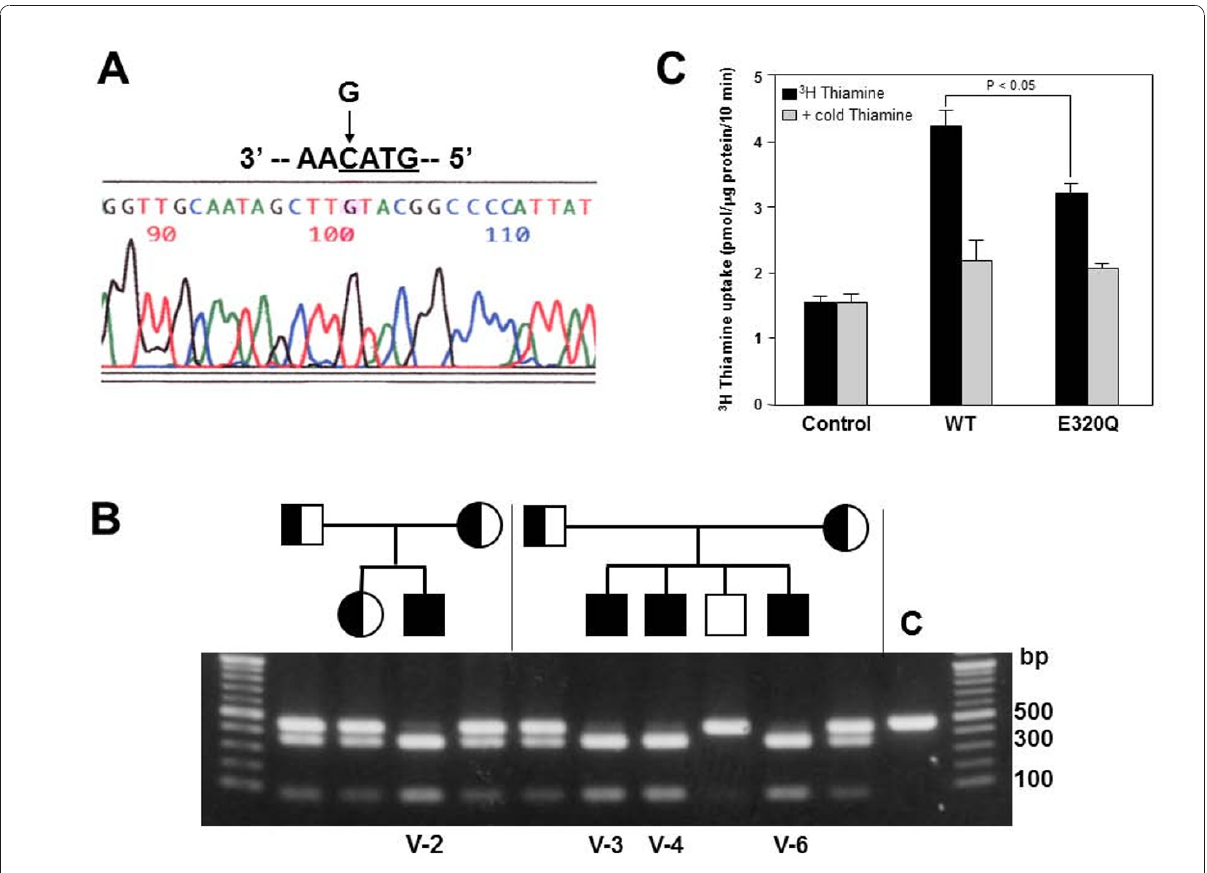
Figure 3 Identification and characterization of a disease mutation (c.958G > C, [p.E320Q]). (A) The sequence analyses showed a G to C substitution at nucleotide position 958 in Exon 3 of SLC19A3 , resulting in a substitution of glutamic acid at codon 320 for glutamine (c.958G > C, [p.E320Q]), indicated by an arrow. (B) Rsa I (GTAC)-digested PCR products were run through a 1.2% agarose gel. Digestion of products containing the E320Q mutation resulted in 357- and 86-bp fragments. All patients (V-2, V-3, V-4 and V-6) were homozygous for the mutation, and their parents were heterozygous for the mutation. (C) [ 3 H]-thiamin uptake by HEK293 cells expressing wild-type or E320Q SLC19A3. Two days after transfection, cells were incubated with 0.1 μ M of [ 3 H]-labeled thiamin (14.8 kBq:0.74TBq/mmol) for 10 min with or without 0.1 mM unlabeled thiamin. Incorporated [ 3 H]-thiamin was measured using a liquid scintillation counter. Results are expressed as mean ± SE of specific uptake values from three independent